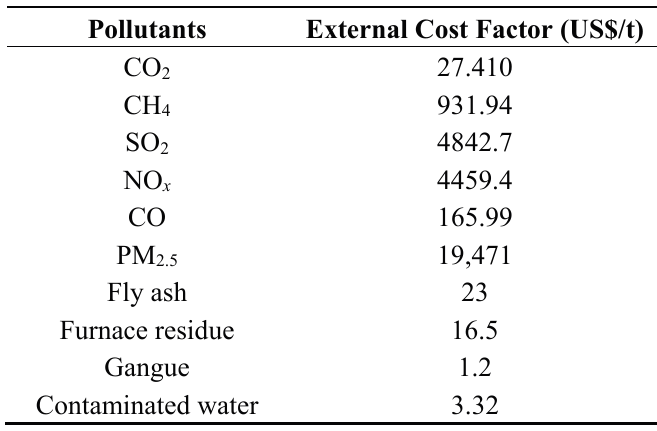
Table 1. External cost factors of pollutants of coal-fired power in China.